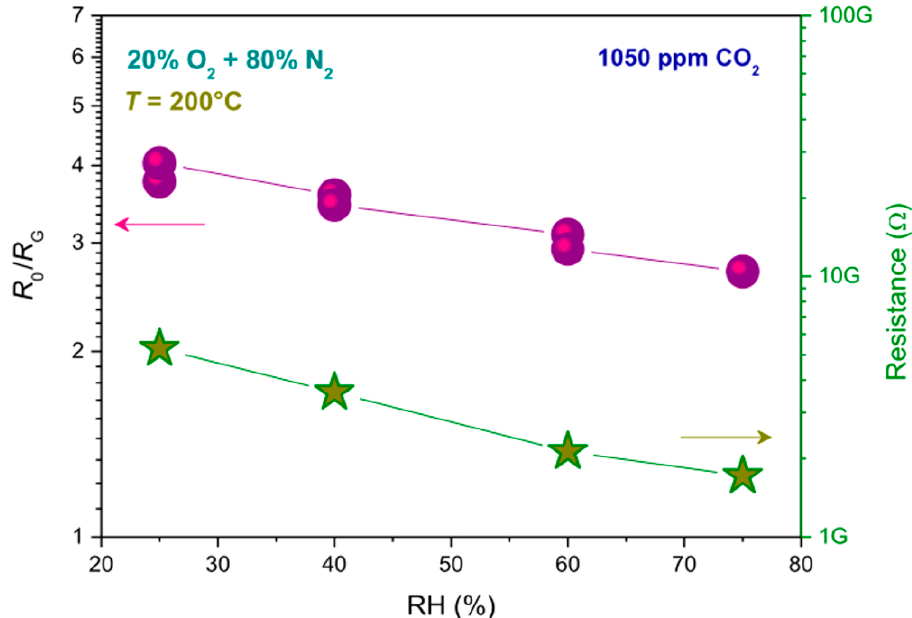
Figure 6. Relative humidity ( RH) effect on baseline resistance (right y -axis) and response (R 0 /R G , left y -axis) of nanofibers-based sensors. Reprinted with permission from Pantò, F. et al., CO 2 sensing